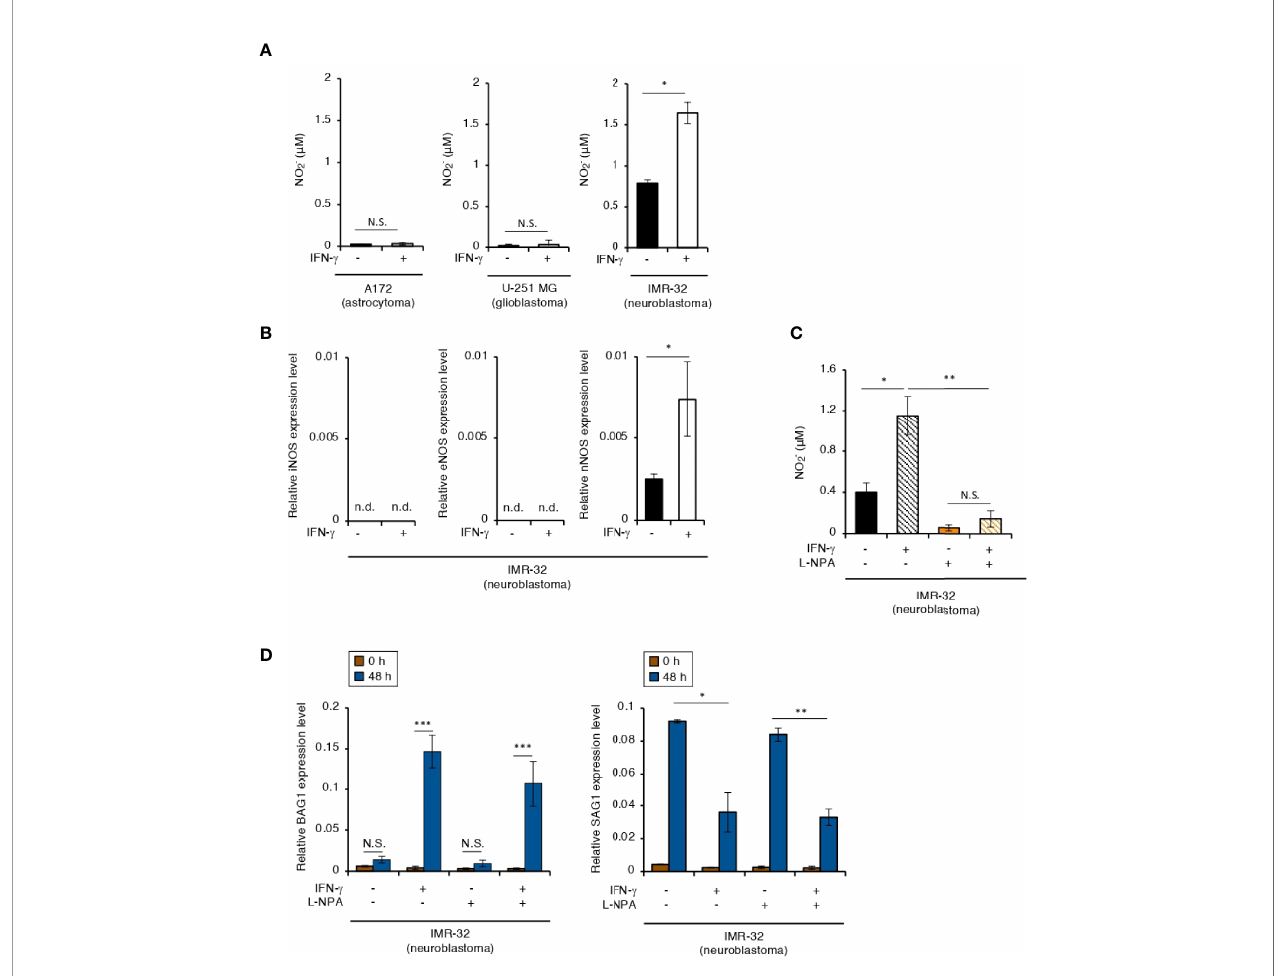
FIGURE 2 | NO concentration plays no role in the IFN- g -dependent T. gondii stage conversion in human neuroblastoma cells. (A) A172, U-251 MG, and IMR-32 cells were untreated or treated with IFN- g and incubated for 0 or 48 h. The level of NO 2 released into the culture supernatant was measured by IC. (B) IMR-32 cells were untreated or treated with IFN- g and incubated for 24 h. The iNOS , eNOS , and nNOS mRNA levels were analyzed by use of quantitative RT-PCR. (C) IMR-32 cells were untreated or treated with IFN- g and/or aminoguanidine and incubated for 48 h. The level of NO 2 released into the culture supernatant was measured by IC. (D) IMR-32 cells infected with T. gondii ME49 were untreated or treated with IFN- g and/or aminoguanidine and incubated for 48 h. Then, the BAG1 or SAG1 mRNA level were analyzed by use of quantitative RT-PCR. Values are means ± SD (three biological replicates per group from three independent experiments) (A – D) . * p < 0.05, ** p < 0.01, *** p < 0.001; N.S., not signi fi cant; Student ’ s t -test. n.d.,